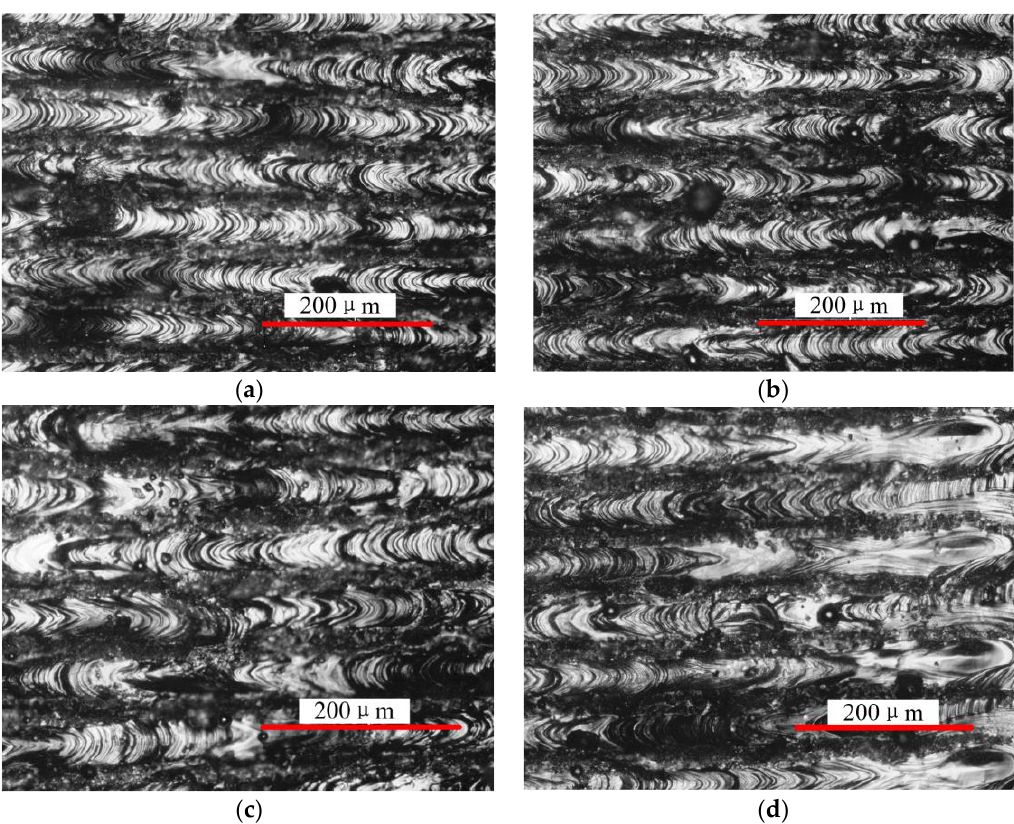
Figure 9. Surface morphologies of SLM-processed AlSi10Mg single layers. The process parameters are: laser power: 320 W, scan speed: 750 mm/s and overlap rate at: ( a ) 0.2; ( b ) 0.25; ( c ) 0.3; ( d ) 0.35.